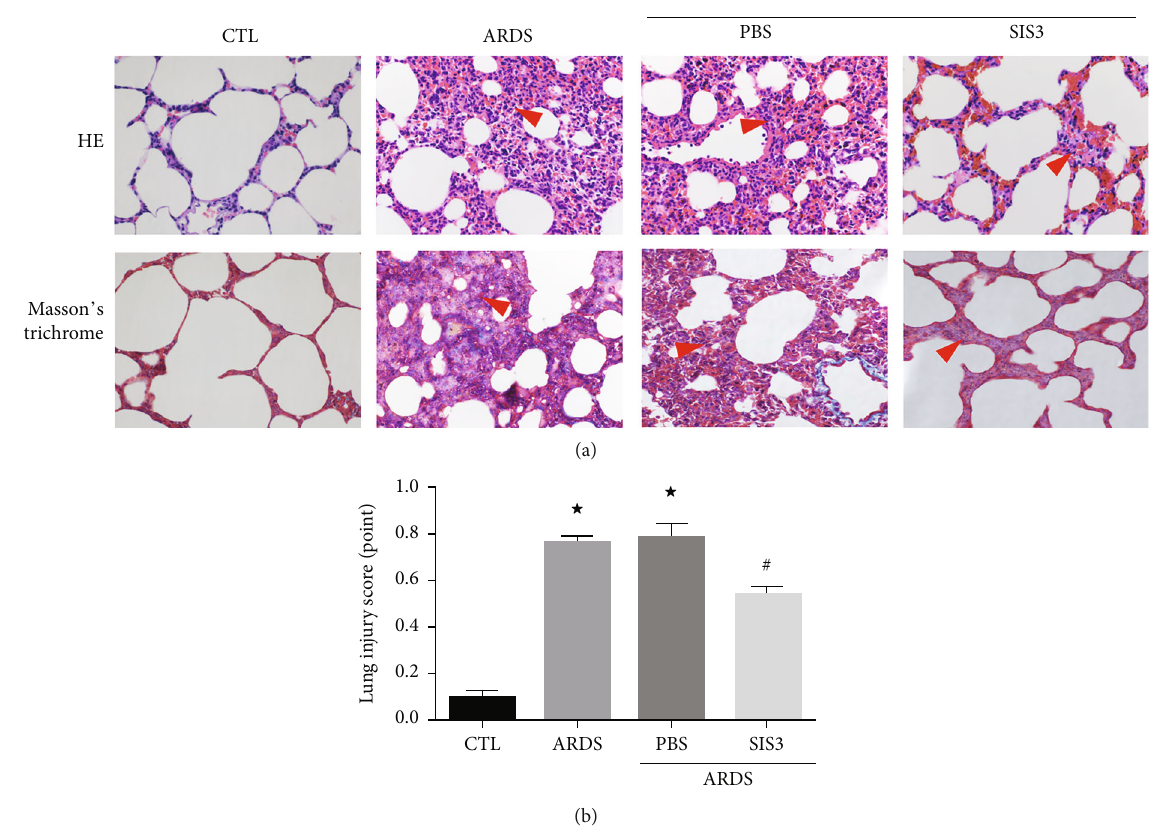
Figure 3: The in fl ammatory response was reduced by SIS3 pretreatment in LPS-induced acute lung injury. (a) Histological staining was performed to compare lung injury among the di ff erent groups. Both HE staining (upper panel) and Masson ’ s trichrome staining (lower panel) show drastic leukocyte in fi ltration in the lung interstitium in the ARDS group, and the leukocyte in fi ltration was markedly alleviated after treatment of SIS3. Masson ’ s trichrome staining reveals abnormal fi brosis and collagen distribution which was stained as blue, in the ARDS group, and signi fi cantly less blue stain is seen in the ARDS group treated with SIS3. The red triangles indicate the in fi ltrated sites. The photomicrographs were magni fi ed to 400x. (b) HE staining was used to score lung injury. In the ARDS group, the lung injury was 0 : 77 ± 0 : 01 , and after treatment with SIS3, the score decreased to 0 : 54 ± 0 : 01 ( ★ P < 0 : 05 vs. CTL; # P < 0 : 05 vs. ARDS). Data are presented as the means ± SD ( n = 10